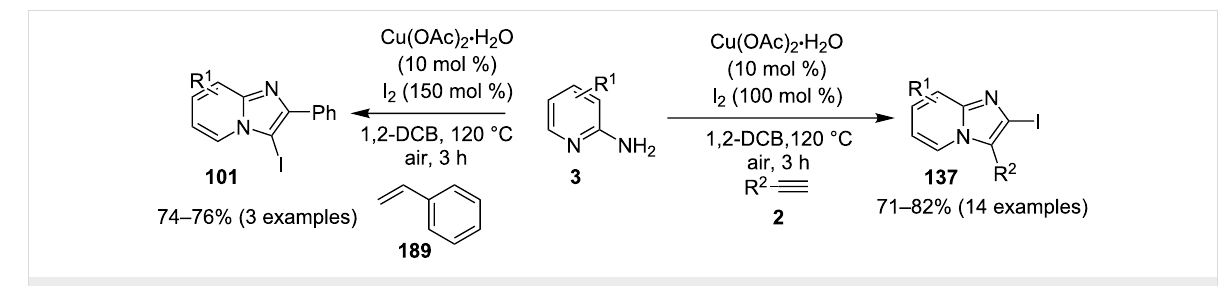
Scheme 64: Plausible mechanism for CuBr-catalyzed